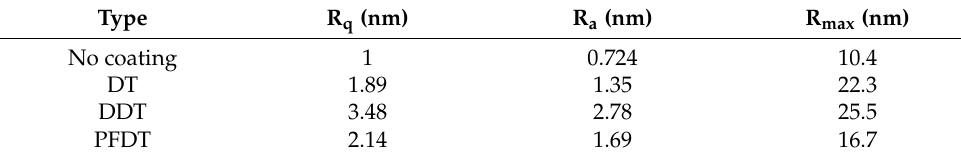
Figure 6. Three-dimensional morphology on the surface of mold insert: ( a ) no coating; ( b ) DT; ( c ) DDT; ( d ) PFDT. Table 3. Surface roughness of SAMs.